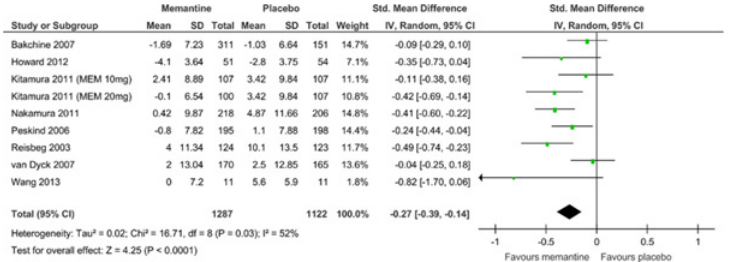
Fig 3. Forest plot of cognitive function (9 comparisons, n = 2409). * Negative SMD values favor memantine; positive SMD values favor placebo. † RR < 1 favors memantine; RR > 1 favors placebo.